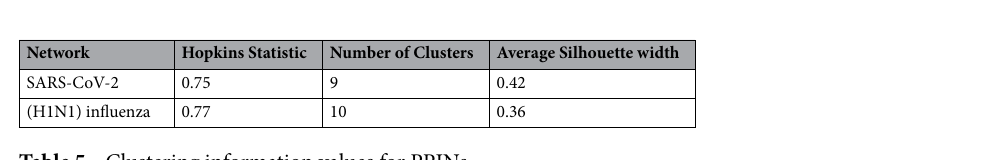
Table 5. Clustering information values for